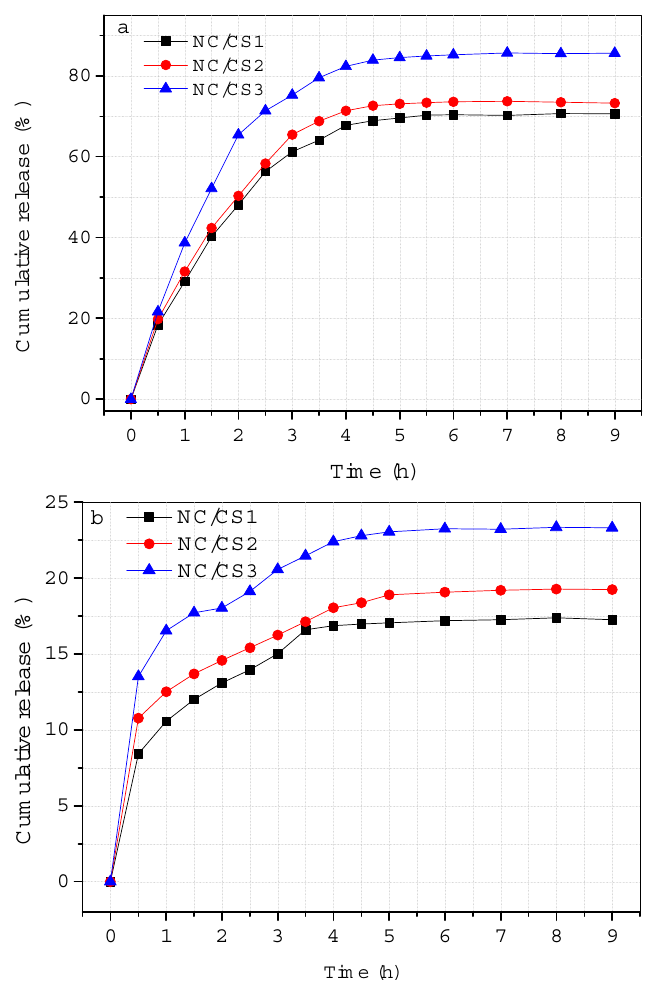
Figure 6. In vitro cumulative drug release from the drug-loaded hydrogels in ( a ) pH 1.5 and ( b ) pH 7.4 buffer solutions at 37 °C.